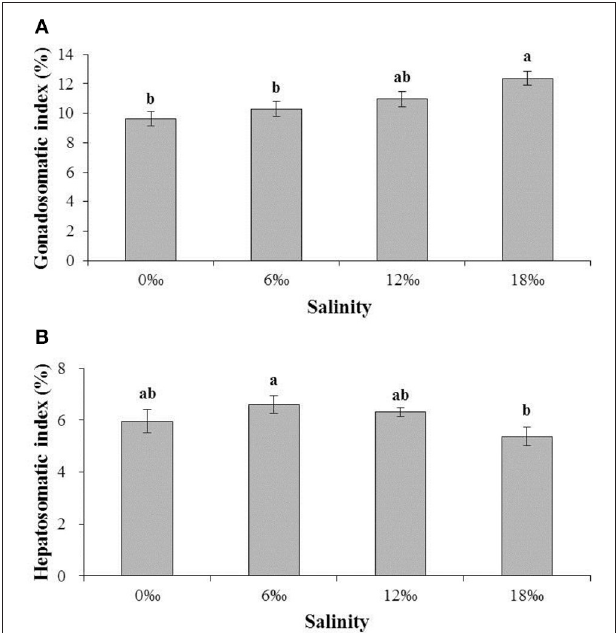
FIGURE 2 | The gonadsomatic index (GSI) (%) and hepatosomatic index (HSI) (%) ( ± SE) of the female E. sinensis subjected to different salinities for 40 days. (A) : GSI; (B) : HSI. Different letters on the tops of the bars indicated significant differences.